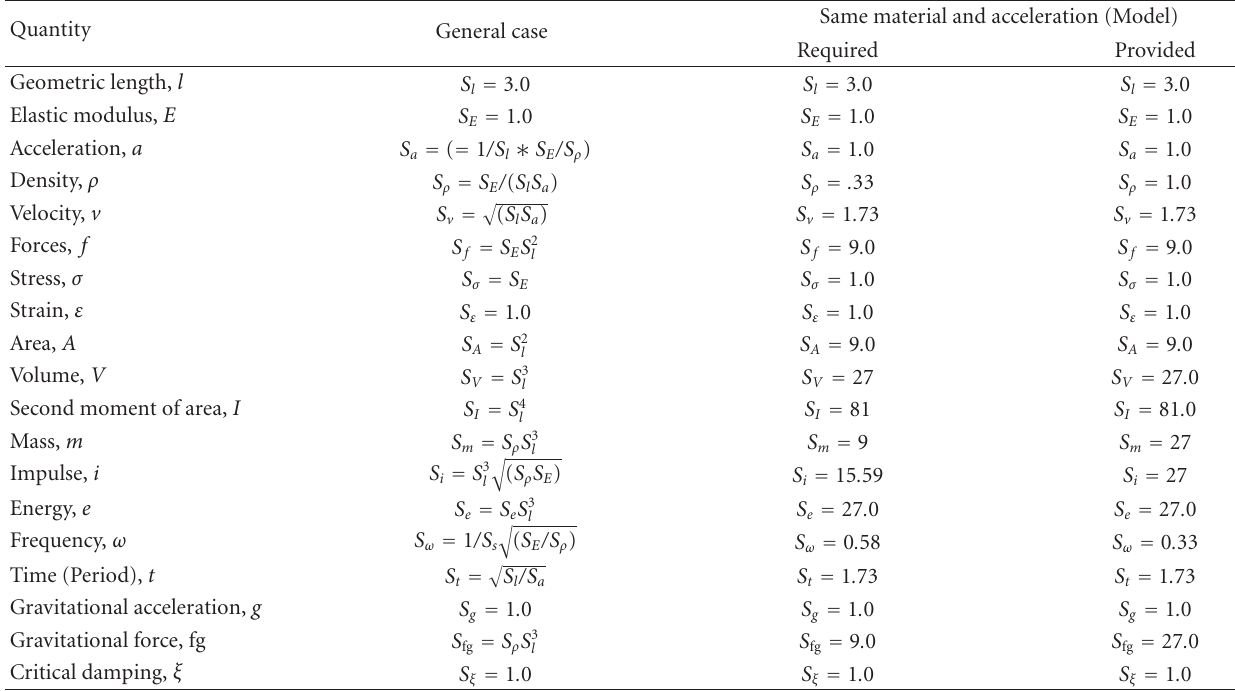
Table 3: Scale factors used for